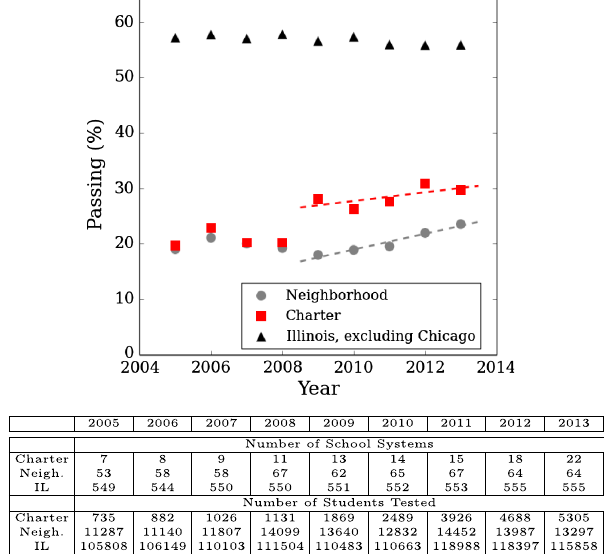
FIG. 6. Percent of Chicago charter and traditional high school students and other Illinois school students who passed the math PSAE each year. There was a performance shift in 2009 among Chicago students after which a greater percent of charter students passed. Neighborhood schools have improved at about 1.5% per year from 2009 to 2013, compared to 0.8% per year among charter schools, as determined from the slopes of each fit. The table gives the number of schools and the number of students tested each year in those